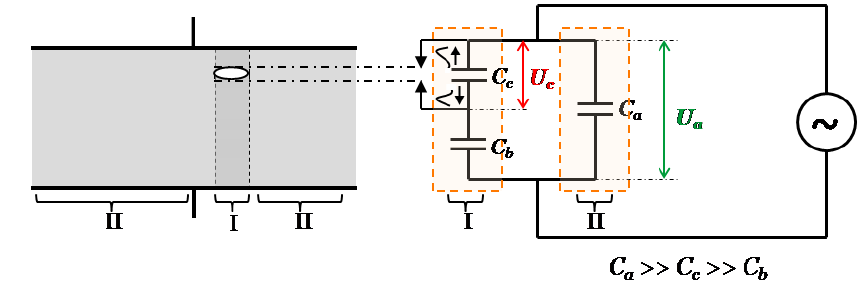
Figure 1. Three capacitance model of a dielectric with a